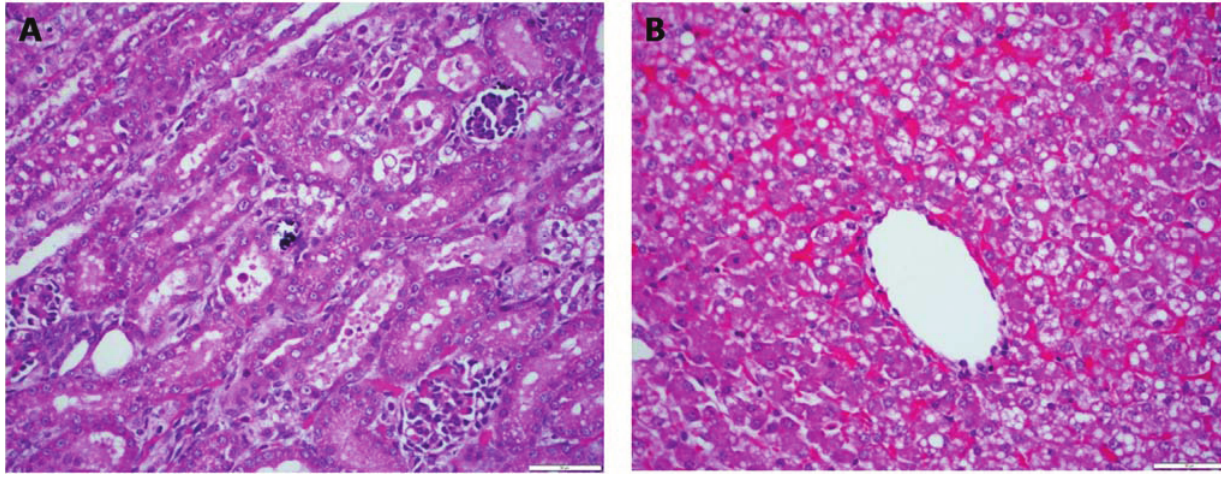
Figure 1 . Case 1. Multifocal areas of acute renal tubular degeneration and necrosis, with multifocal mineralization of the tubular basement membrane ( A ). Marked dissociation of the hepatocellular cords, multifocal hepatocellular necrosis, central congestion and prominent vacuolation of hepatocytes ( B ). H&E stain